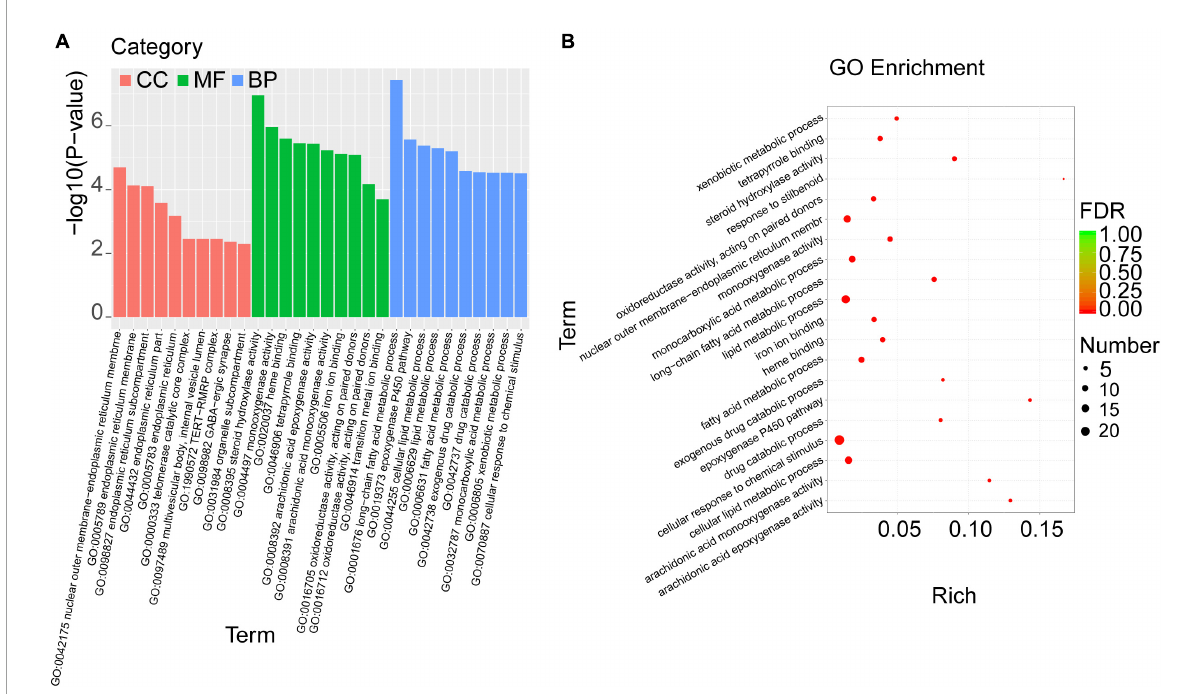
FIGURE5 GO enrichment analysis was performed with the overlapped DEGs. (A) The categories in GO terms included cellular components (CC), molecular function (MF), and biological process (BP) were analyzed. (B) The top 20 significant GO terms of the overlapped DEGs in livers were chosen based on the order of p value from small to large.